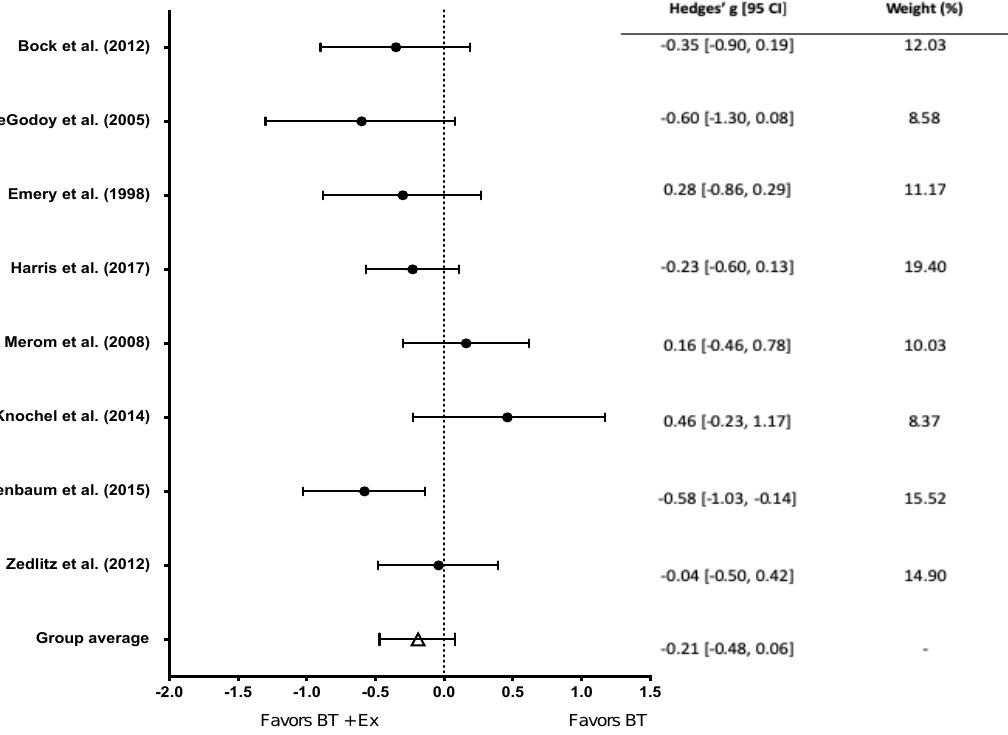
Figure 6. Overall effect of BT+Ex on anxiety. Test for overall effect g = −0.21, p > 0.05. BT+Ex = Figure 6. Overall e ff ect of BT + Ex on anxiety. Test for overall e ff ect g = − 0.21, p > 0.05. BT + Ex = Behavioral Therapy + Exercise, BT = Behavioral Therapy only. Behavioral Therapy + Exercise, BT = Behavioral Therapy